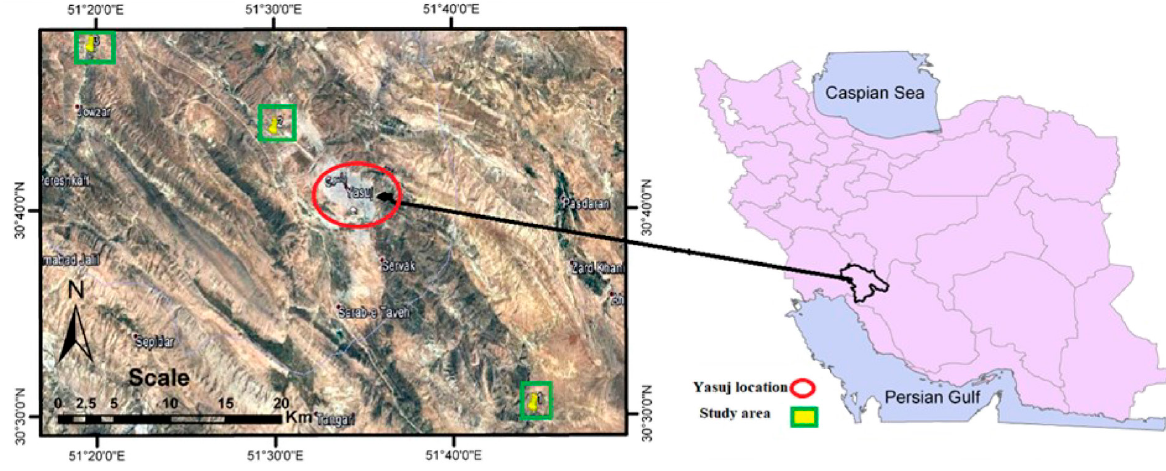
Figure 1 Location of Yasuj, southwest of Iran and the study area (site A: 30.502935, 51.743184, site B: 30.710630, 51.514926, site C: 30.789658,